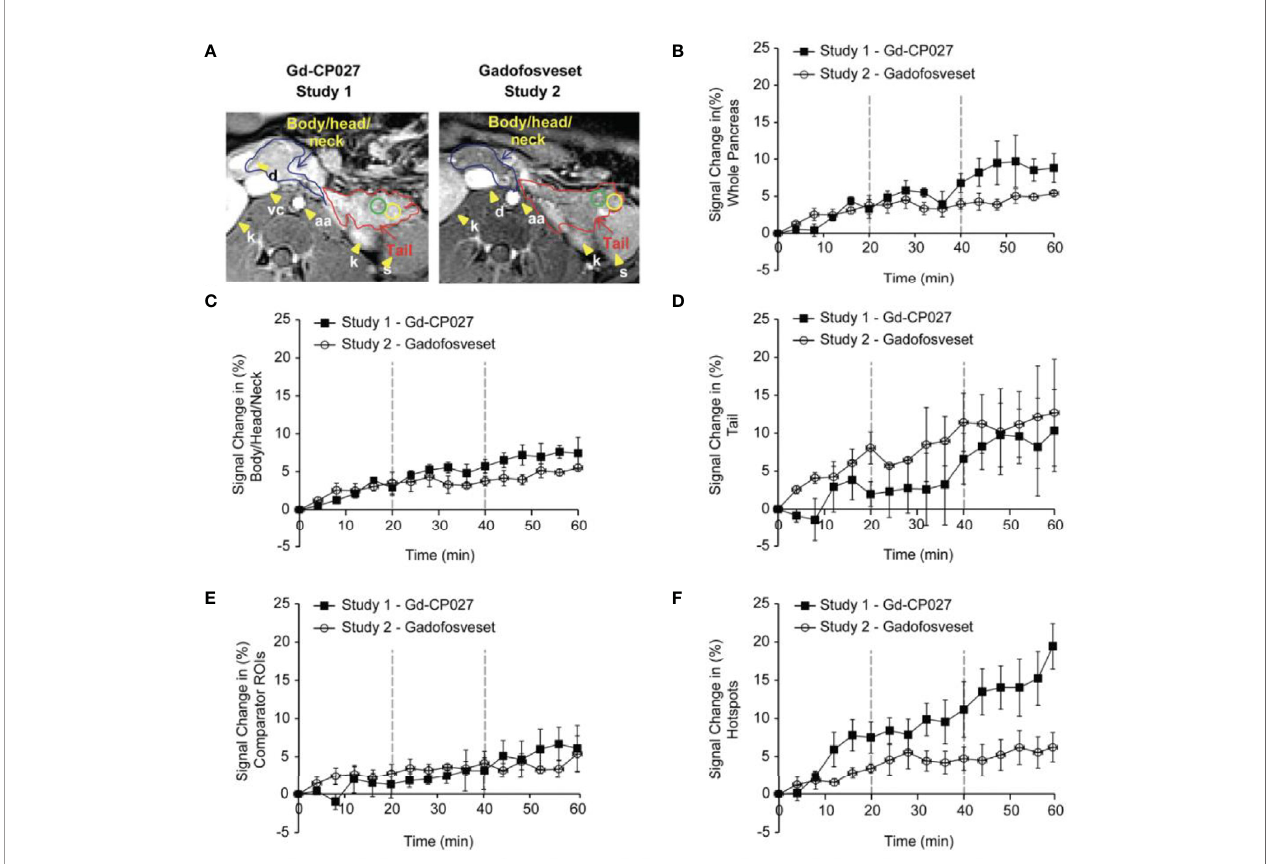
FIGURE 3 | (A) Non-human pancreas segmentation delineating the tail (red outline), body/head/neck (blue outline) and ROIs within the tail. Change in signal intensity (%) after infusion of each agent alone (0-20 min) and after graded increases in glucose (20-40 and 40-60 min). for (B) the entire pancreas, (C) Body/Head/Neck, and (D) Tail of the pancreas. The error bars re fl ect standard deviations for the 4 animals. (E) Change in MRI signal intensity (%) for within-slice comparator ROIs for the 4 animals. (F) Change in MRI signal intensity (%) within the regions identi fi ed as hotspots in the 4